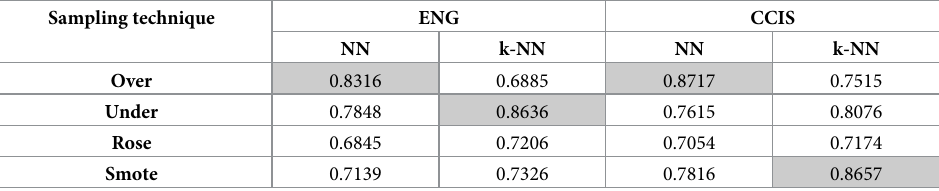
Table 8. The prediction accuracy obtained using NN and k-NN classifiers to ENG and CCIS